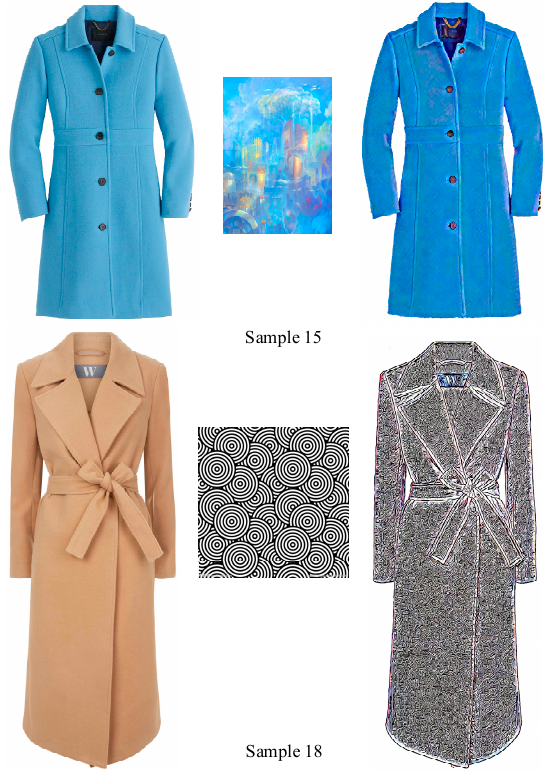
Figure 12. Style transfer results of sample 15 and 18.